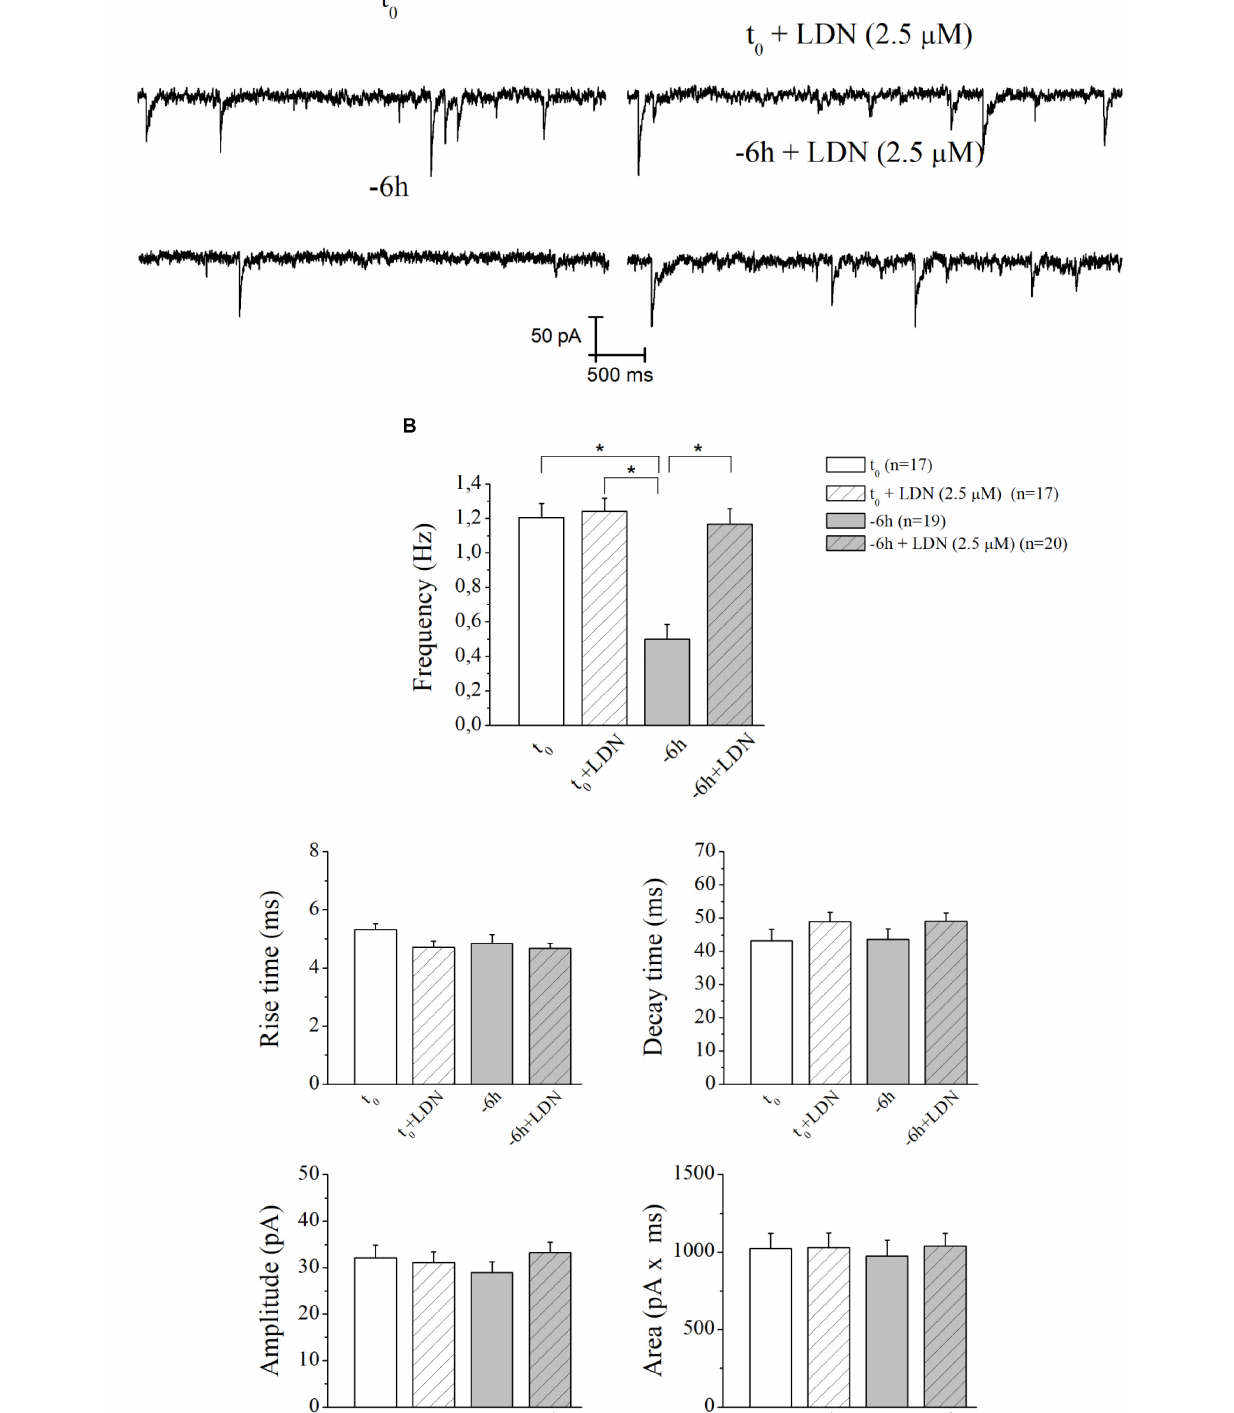
FIGURE 7 | The decay in mEPSCs frequency of NGF-deprived cultures is also recovered by LDN treatment. (A) Representative traces of septal neurons grown for 10–12 D.I.V. in B27 0.2%+NGF, deprived for 6 h of NGF, in the absence and presence of LDN UCHL-1 inhibitor (2.5 mM) were shown. (B) Bar plots reported the mean ± SEM of frequency, amplitude, rise time, decay time and area of the mEPSCs recorded in neuronal populations under different experimental conditions. The